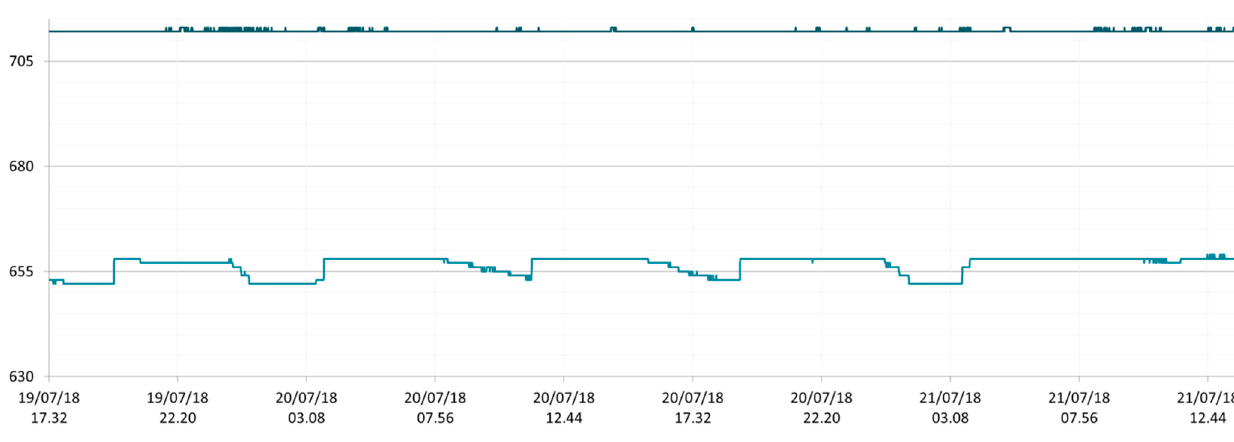
Figure 11. Zoom of the raw patterns of valve openings of two individuals of P. casertanum included in the second study group, from 19 to 21 July 2018: HUB03-01 in blue colour, HUB03-02 in heavenly colour.